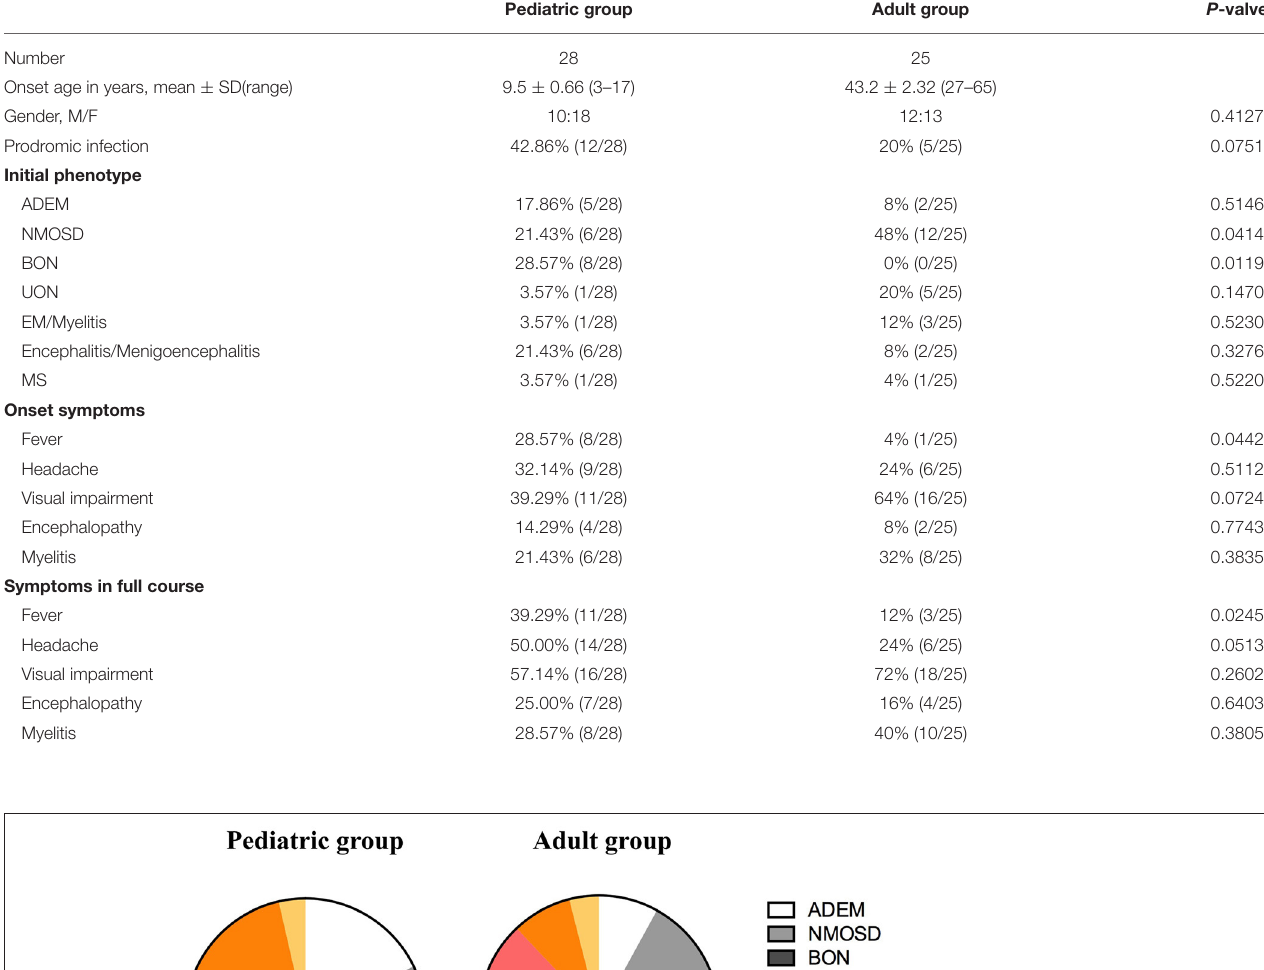
TABLE 1 | Comparison of the demographic and clinical characteristics of the pediatric and adult patients. Pediatric group Adult group P